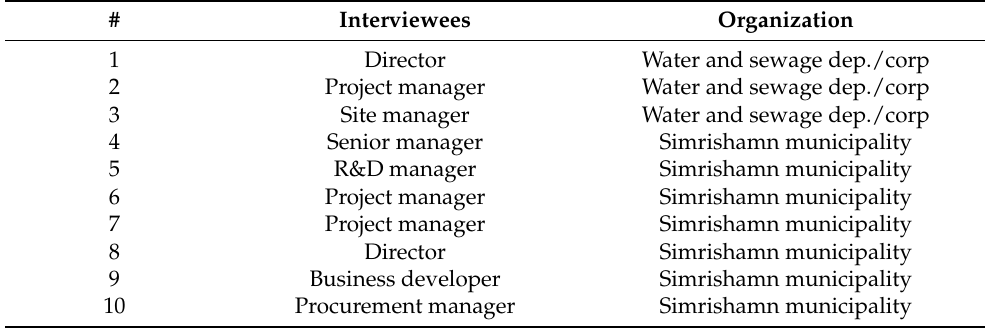
Table 2. Interviews conducted relevant for the change in organization form in the